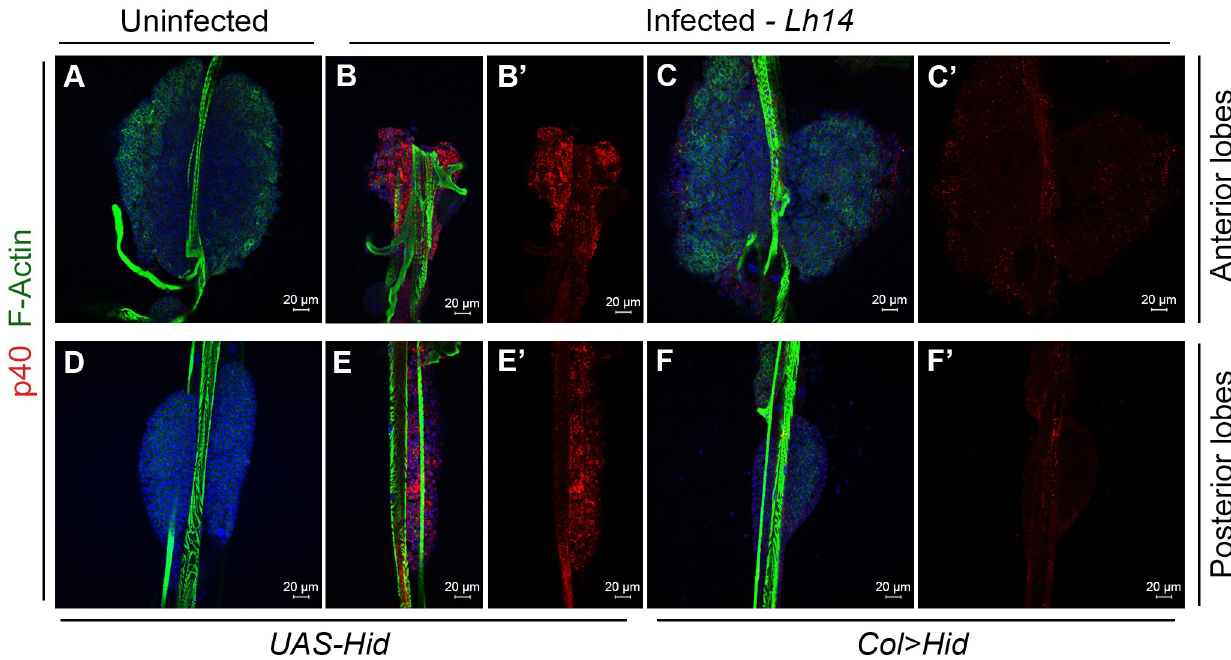
Fig 3. PSC-less lymph glands from Lh- infected animals have intact lobes. ( A, D ) Lobes from a na ï ve UAS-Hid host are intact and lack EVs; anterior ( A ), and posterior lobes ( D ). ( B, E ) Lymph gland from a Lh -infected UAS-Hid host is depleted of hemocytes and has many EVs. Anterior lobes ( B, B’ ), and posterior lobes ( E, E’ ). ( C, F ) PSC-less lobes from a Lh -infected Col > Hid host are intact with weak EV signal. Anterior ( C, C’ ), and posterior lobes ( F, F’ ).